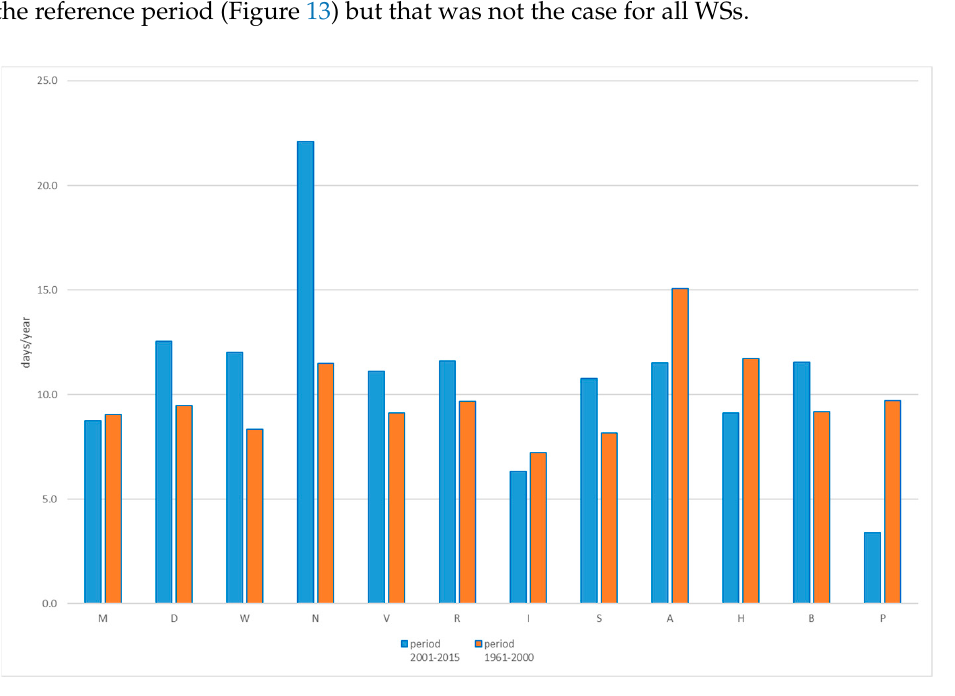
Figure 13. Mean number of low-flow event days from 2001–2015 compared to 1961–2000. For the Q 364d limit, no low-flow period with Q d < Q 364d was detected at nearly half of WSs, an increase in the occurrence, compared to the 1961–2000 period, is visible.